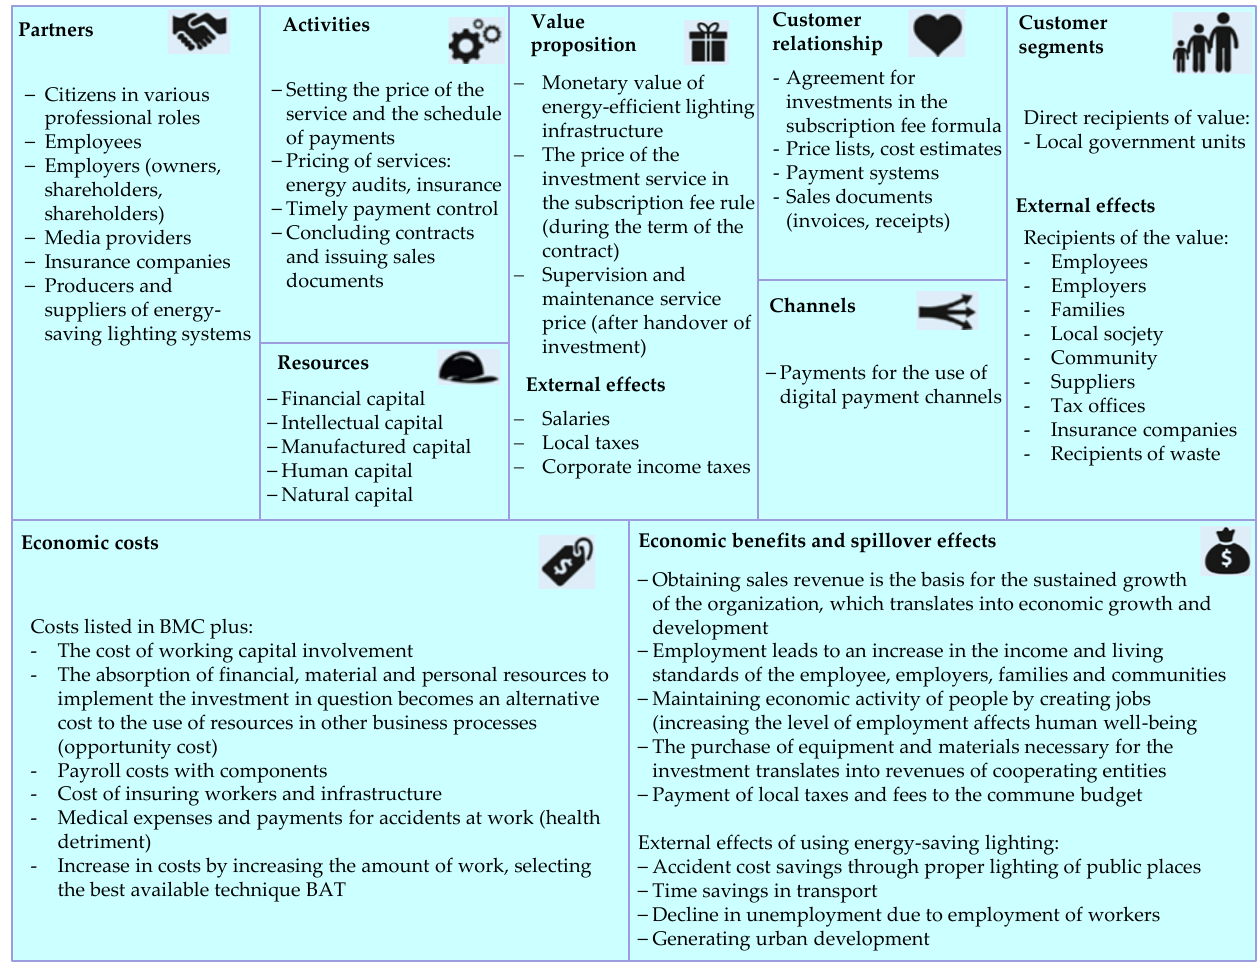
Figure 8. The economic layer of sustainable development. Source: Own study based on the source [59]. Start-up activity exerts a complex impact, of various nature, on the economy {positive, neutral, negative}, of different type {direct, indirect, induced}, scale {micro, meso, macro}, duration {short-term, long-term}, intensity {small, medium, large}. The positive external effects of micro and macro innovation include the marketing of innovative products or services. At the scale of the economy, start-ups create innovative solutions that force suppliers or partners to make changes that would enable orders to be fulfilled, stimulate quality changes in suppliers’ products and services in the value chain. Making changes can be the basis for creating the next generation of services and products. At the micro level, the major categories of positive impacts include: provision of employment and through the payment of remunerations and benefits increasing the household budgets, creation of added value, enabling it to survive and thrive. On a macro scale, innovative solutions used by other actors influence the innovativeness of the economy and its competitiveness on the international market. The creation of added value which is the most important component of the GDP increases the financial potential of the country, and the start-up also influences the condition of public finance through the payment of local and national taxes. The described economic dimension of sustainable development and its model provide the answer to the second research question (RQ2) and contribute to the scientific goal of the